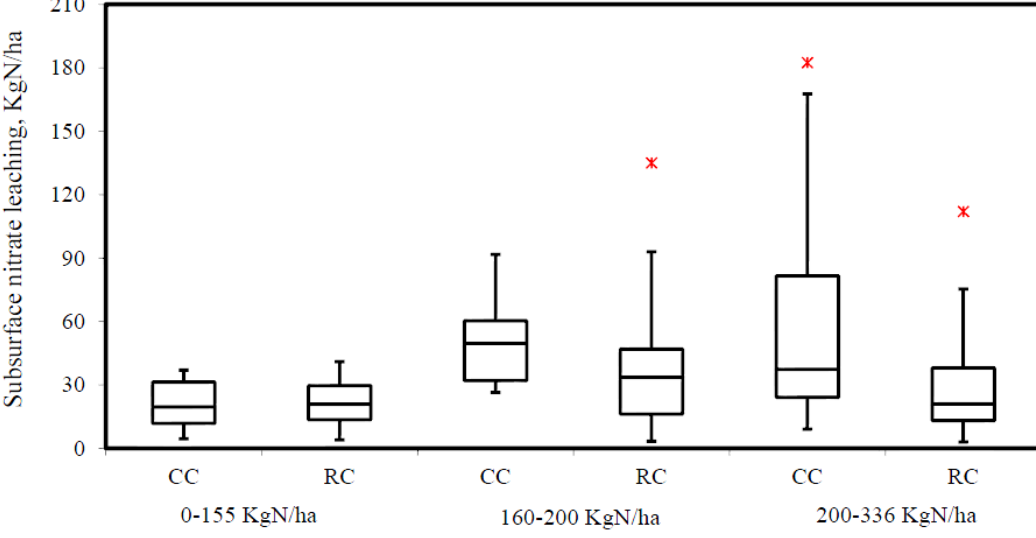
Figure 9. Nitrate leaching from silty loamy soil in continuous corn (CC) and rotated corn (RC) (six and eleven journal articles were used for analysis). CC: continuous corn, RC: Corn in rotation.